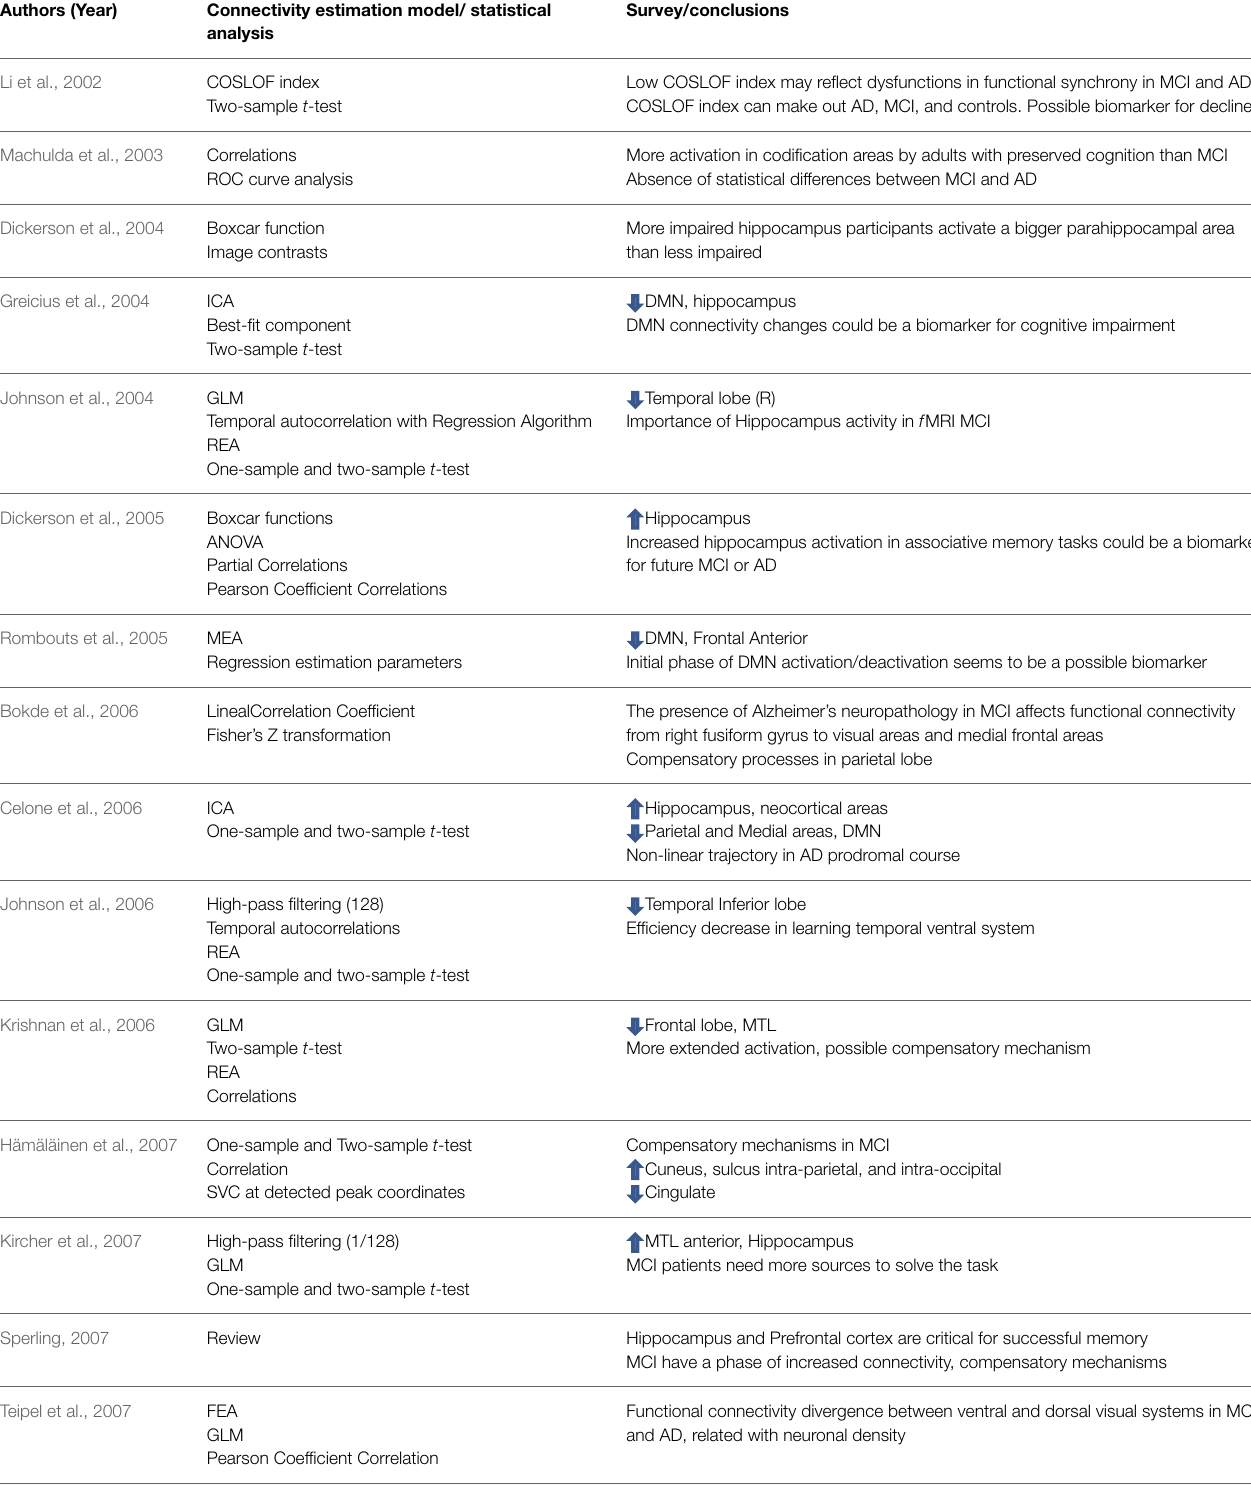
TABLE 1 | Detailed results of selected articles in the survey. Authors